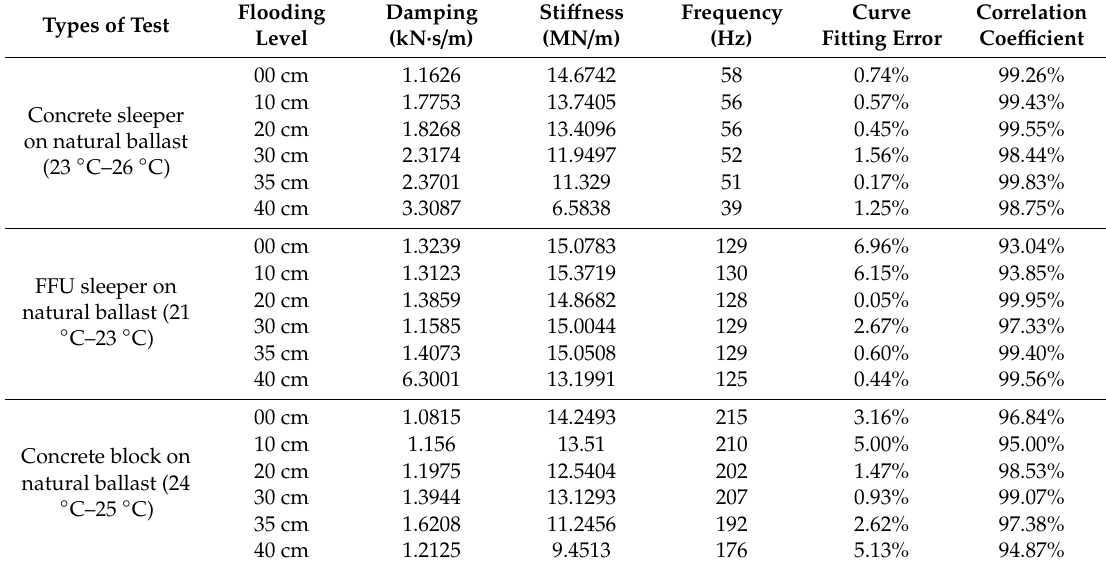
Table 3. The dynamic properties’ changes with flooding level.